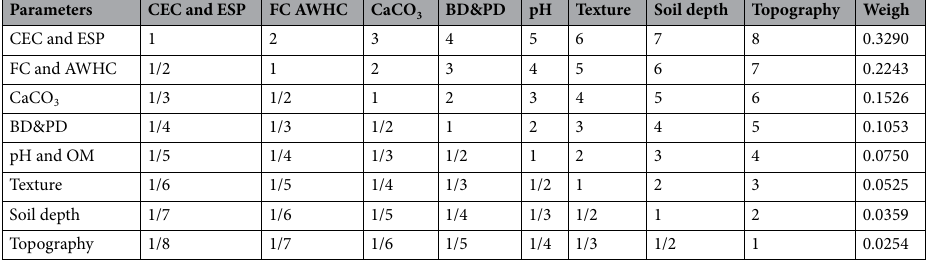
Table 5. Pair wise comparison matrix for crops suitability according to Saaty.